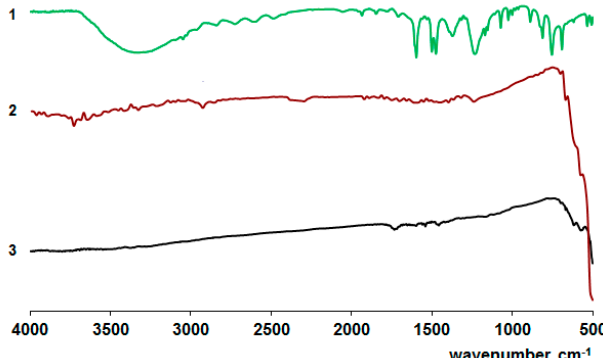
Figure 13. IR spectra of initial phenol (curve 1), its decomposition products in the presence of composite [( ≡ TiO) n ]:[HEMA]:[AN] + Ag NPs under UV-irradiation (curve 2), under visible light irradiation (curve 3). Time of light irradiation is 400 min.